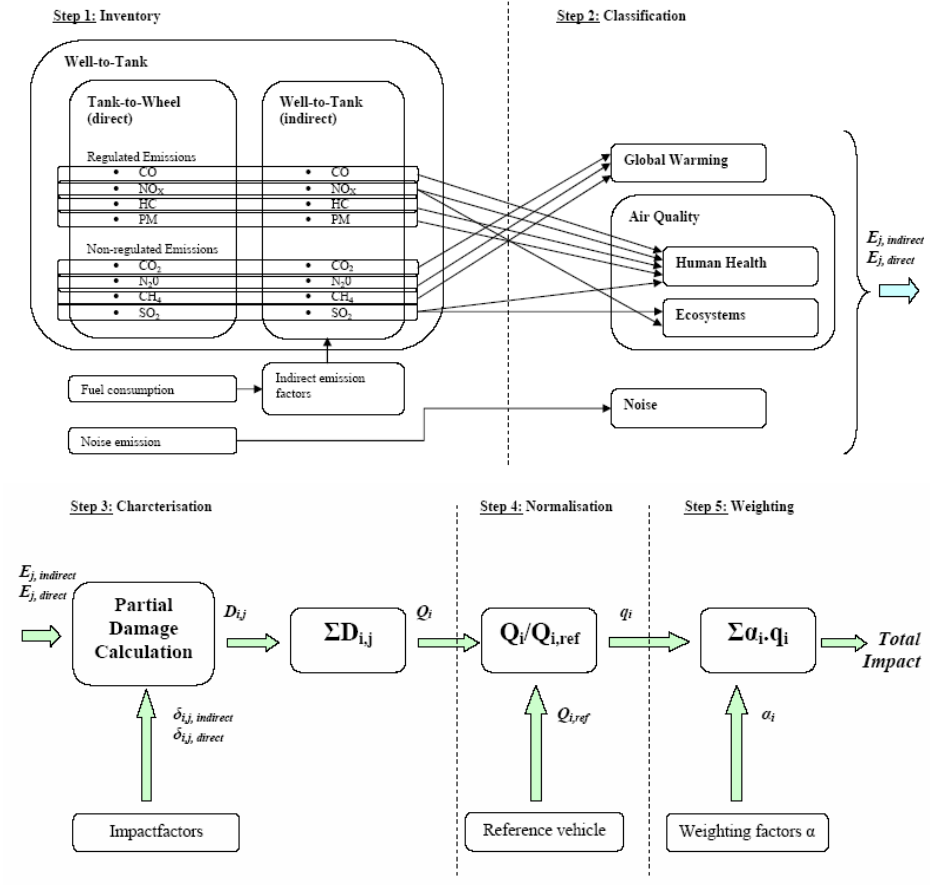
Figure 2. Ecoscore Methodology Overview